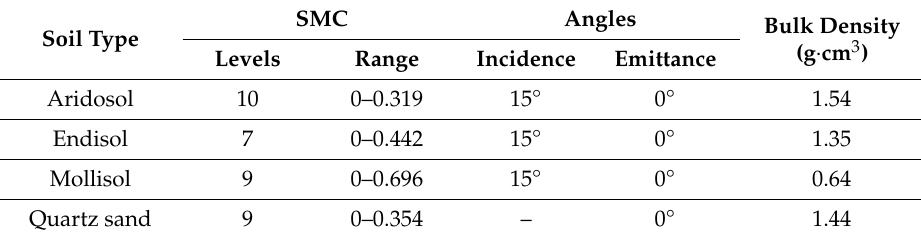
Table 4. Summary of the main information on the